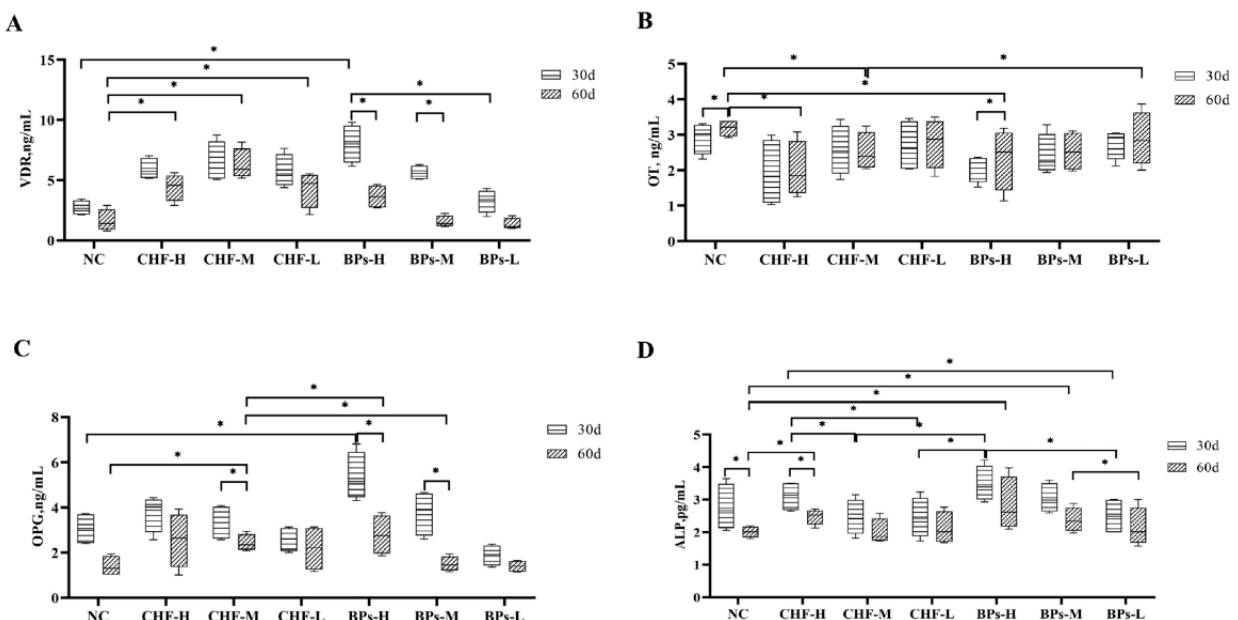
Figure 4. Comparison of biochemical indicators related to bone metabolism in serum. ( A ) Comparison of the VDR content in serum. ( B ) Comparison of OT content in serum. ( C ) Comparison of OPG levels in serum. ( D ) Comparison of ALP levels in serum. * indicates significant difference ( p < 0.05).